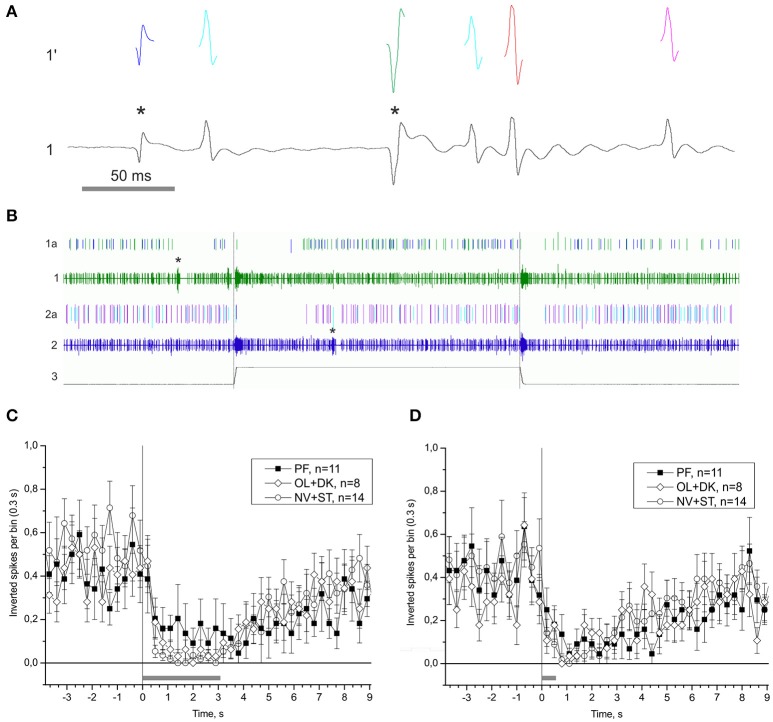
Single unit analysis of statocyst efferent firing rate. (A) Efferent action potentials to statocyst appear as inverted spikes in our extracellular records. 1—n. vestibularis record, 1′–spikes event derived from the record 1. Asterisks mark inverted spikes, which analyzed as separated channel. (B) Extracellular record of activity of the left and right statocysts: 1, n. vestibularis sin.; 2, n. vestibularis dex.; 1a and 2a, virtual channels derived by spike sorting of nerve activity, representing presumed efferent activity to the corresponding statocyst. In this example each nerve transmits spikes from two presumed efferent cells revealed by spike shape and shown in different colors. Note the OFF-responses in activity of efferents to spontaneous bursts in statocyst activity (marked by asterisks) and to bursts elicited by tilts (trace 3, 60 s between tilts). (C,D), Averaged peri-stimulus curves of efferent firing rate to stimulus of 3,050 ms duration (C) and of 550 ms duration (D). Tilt duration is given by the gray bar at the bottom of each plot.